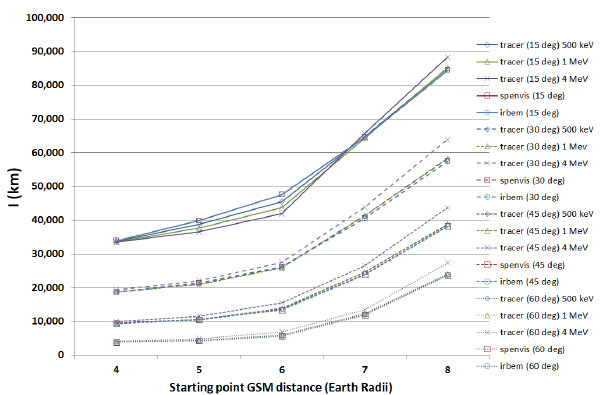
Figure 3. Calculations of I as a function of initial distance (in R E ) at 12:00MLT, for pitch angles of 15, 30, 45 and 60 ◦ and disturbed solar wind conditions.